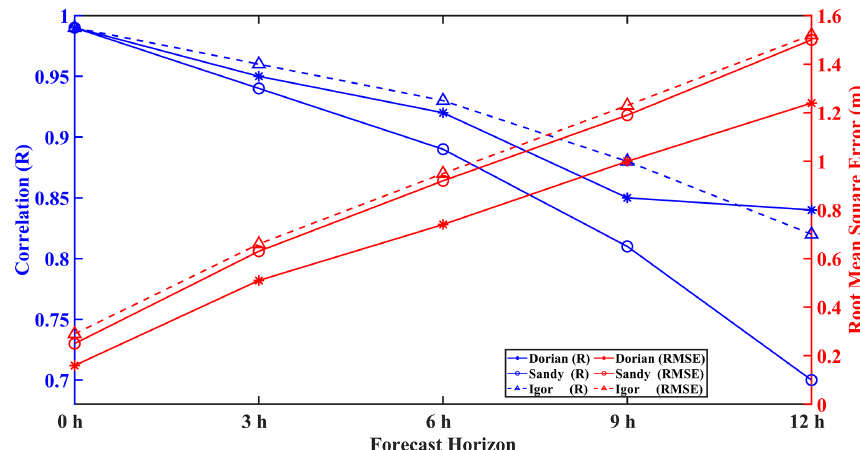
Figure 10. LSTM model forecast performance in terms of R (blue) and RMSE (red) compared with the observations for Hurricanes Dorian, Sandy, and